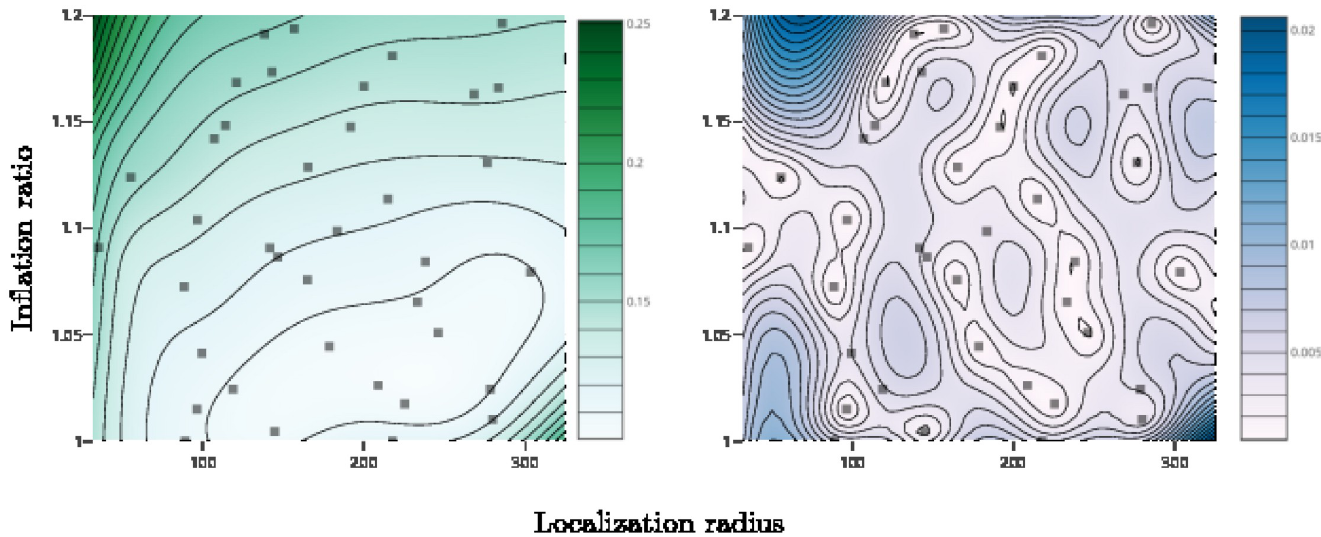
Fig 5. The Gaussian process (GP) model of analysis CRPS for the pure ESRF model at N = 400, showing analysis CRPS as a function of localization radius L and inflation ratio r . The left panel shows the mean of the GP and the right shows the standard deviation. The small gray squares indicate parameter values where experiments were